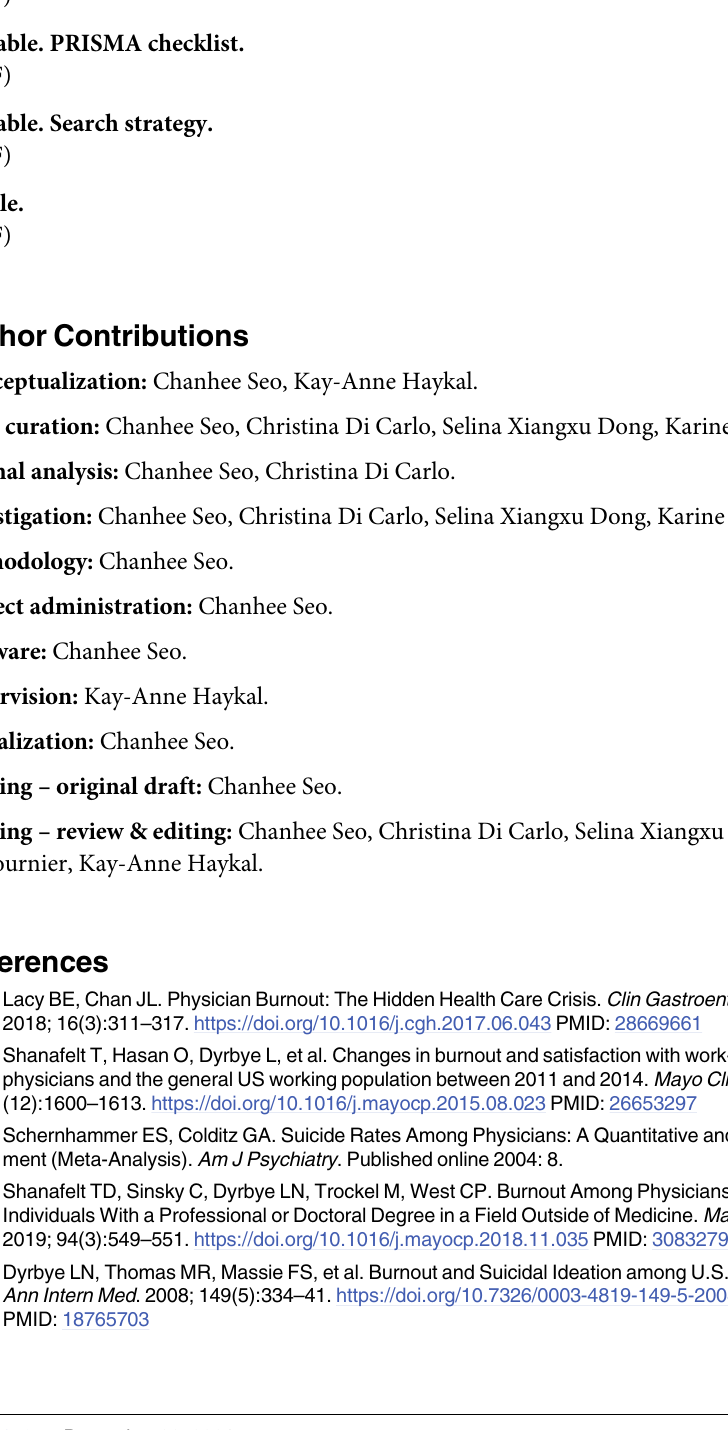
S1 Fig. Forest plots for suicidal ideation risk factors. S2 Fig. Forest plots for suicide attempt risk factors. S3 Fig. Funnel plot of studies reporting female gender as a SI risk factor. S1 Table. PRISMA checklist. S2 Table. Search